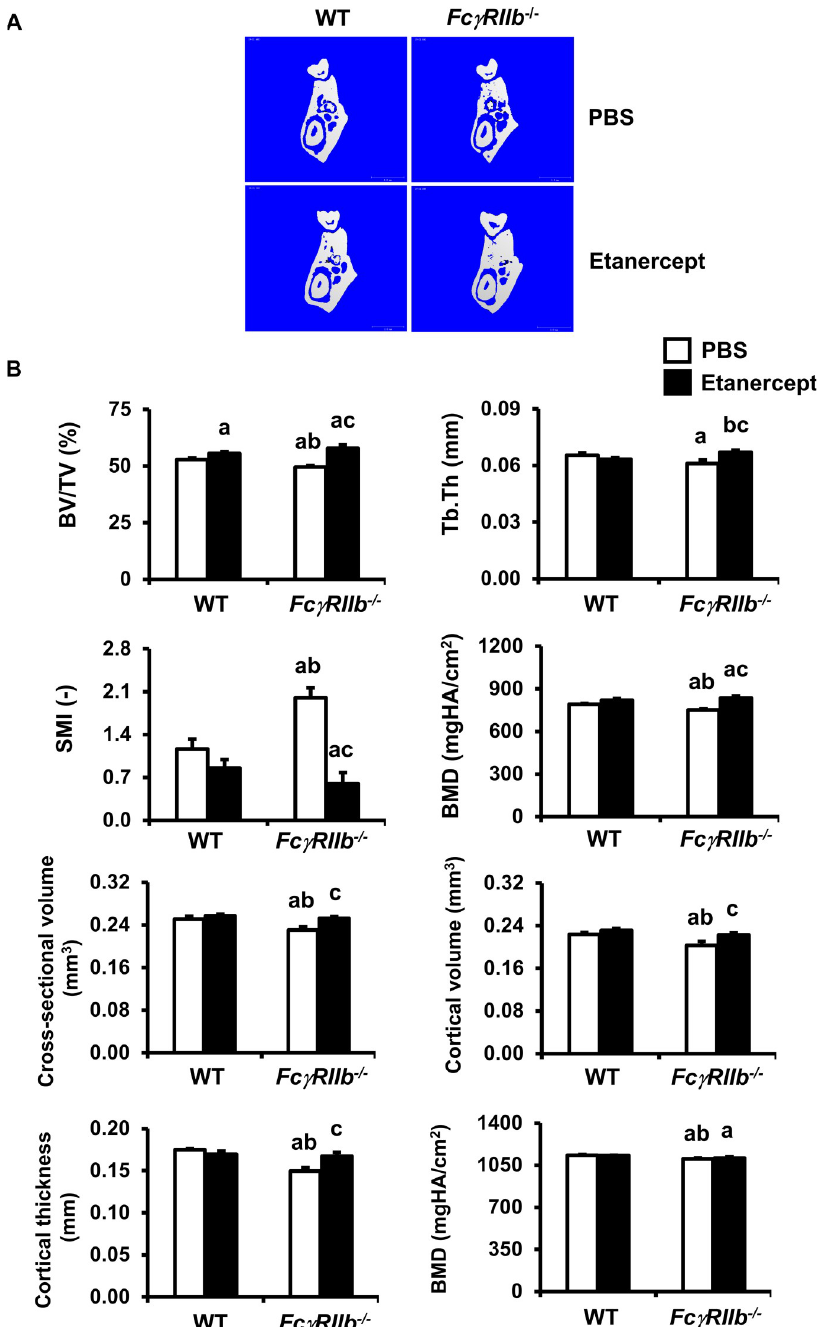
Fig 2. Mandibular cancellous and cortical bone loss are rescued by TNF- α inhibitor in Fc γ RIIb -/- mice. (A) Representative μ CT images of mandibular bone from Fc γ RIIb -/- mice and WT controls after treatment with either PBS or etanercept. (B) μ CT analysis of cancellous and cortical bone in the mandibles from Fc γ RIIb -/- mice and WT controls after treatment with either PBS or etanercept. Data are mean ± SEM (n = 6–8). a p < 0.05 versus WT controls-treated with PBS, b p < 0.05 versus WT controls-treated with etanercept, and c p < 0.05 versus Fc γ RIIb -/- mice treated with PBS.